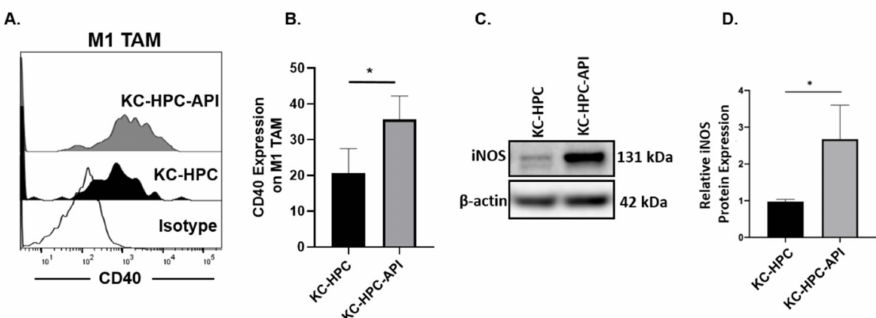
Figure 9. API treatment of KC-HPC mice increased CD40 expression on M1 TAM and iNOS in the tumor. ( A , B ). Flow cytometric analysis of CD40 expression on M1 TAM